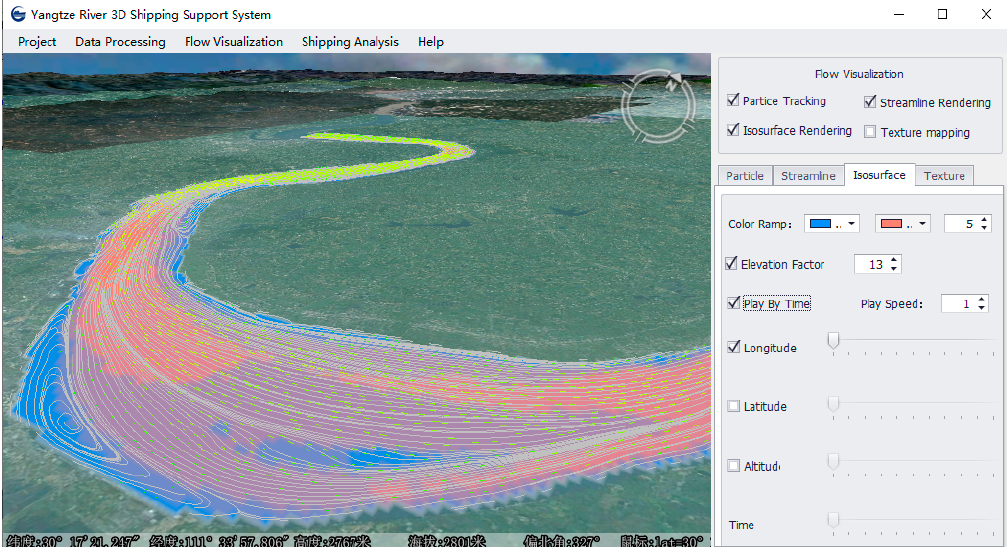
Figure 14. Real-time shipping state analysis (combining particle tracking, streamline rendering, and texture mapping). Considering the multi-dimensional visualization models, Root Mean Square Error (RMSE) or r 2 are not suitable criteria, so Frame Per Second (FPS) and memory amount are used as the benchmark to evaluate the rendering efficiency quantitatively [39,40]. Table 2 shows the experimental results of the different rendering models and combinations. The performance is evaluated at a 1286×900 screen